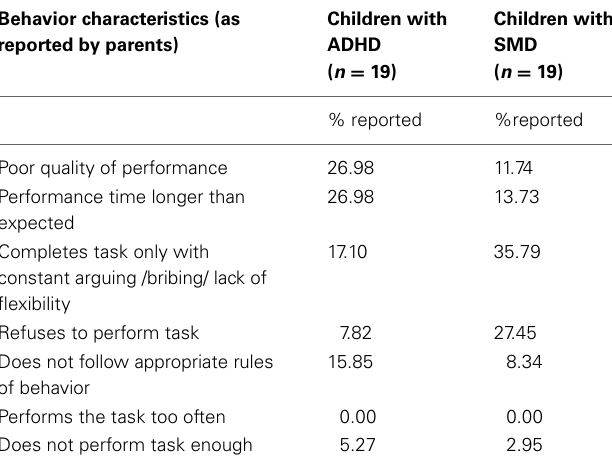
Table 3 | PICO-Q: Comparison of behavior characteristics of children with ADHD and SMD underlying poor performance as reported by